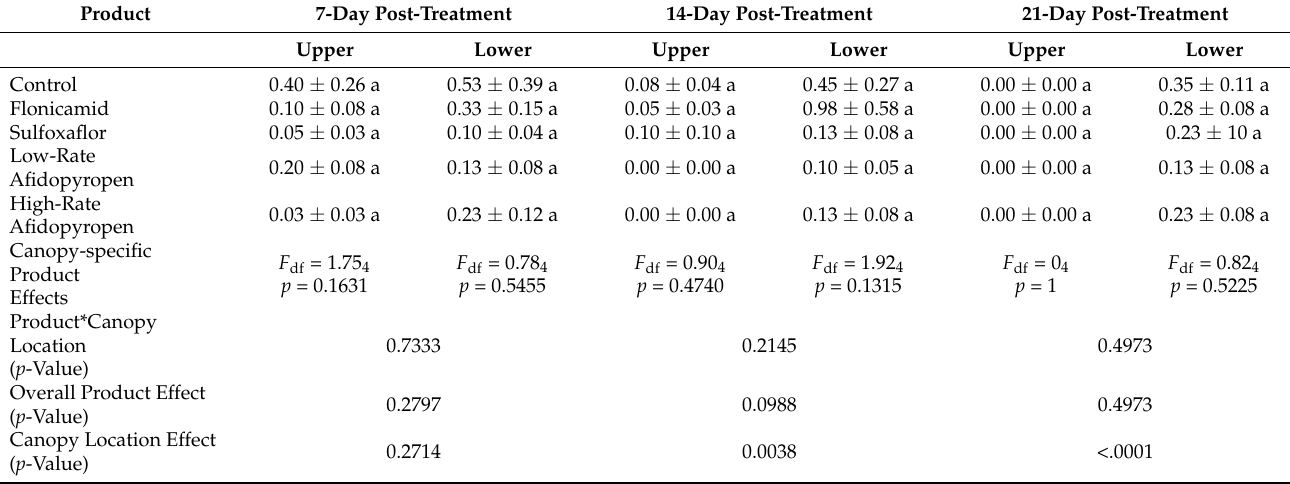
Table 2. Mean ± SEM of mummified aphids per leaf across treatments and sample days in 2019. Differing letters in columns indicate a significant difference between treatments ( p < 0.05 Tukey’s HSD). Canopy-specific product effects and p -values for product*canopy interaction, overall product effect, and canopy location across sampling days are also shown. Application rates for each aphicide are based on the standard label